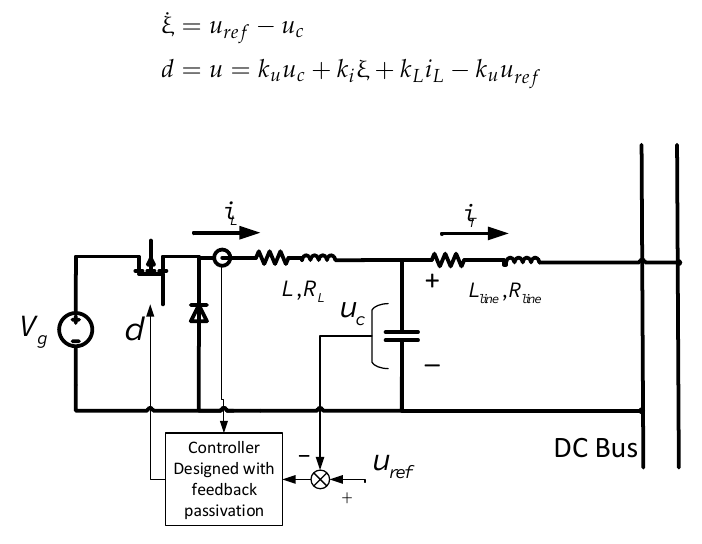
Figure 4. A grid-connected buck converter, operating in the voltage source